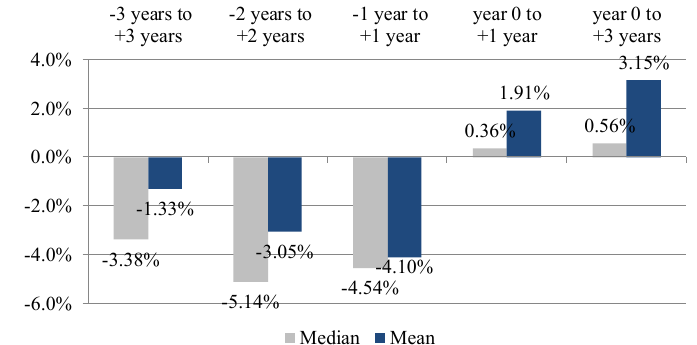
Fig. 6 - Values of the median and the mean (%) for the sample of changes in return on equity in selected time inter- vals (measured in years). Source: Own